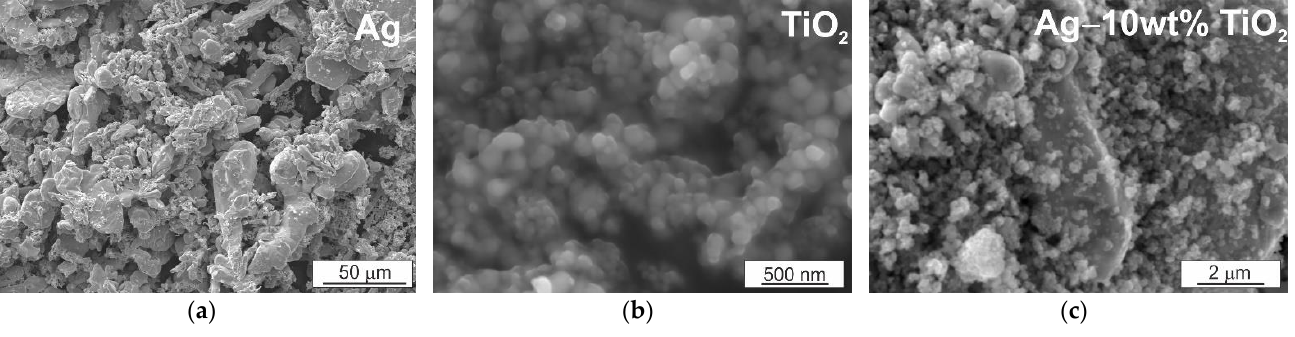
Figure 1. Powder morphology: ( a ) Ag (0–63 µm); ( b ) nano TiO 2 ; ( c ) Ag–10wt% TiO 2 ; SEM. The composites were produced in a single-action compaction press followed by sintering under nitrogen atmosphere at 900 ◦ C for 1 h. Pressures of 400 MPa and 500 MPa were used for pressing, no lubricants were used, and they were cold pressed. In order to increase the density of the composites, the pressing operation was conducted at the same pressure and the samples were successively sintered under nitrogen atmosphere at the temperature of 650 ◦ C for 1 h. The secondary pressing process was used to improve the density of the tested materials, the density of which after the first pressing was not sufficient. The second sintering is treated more as a procedure of eliminating internal stresses and recrystallization with a possible increase in the contact surface between the particles as a result of diffusion processes. The TiO 2 reinforcement phase was added in amounts of 5 wt% and 10 wt%. Samples with dimensions of 4 × 5 × 40 mm were produced. The scheme of Ag–xTiO 2 composite manufacturing process is presented in Figure 2.